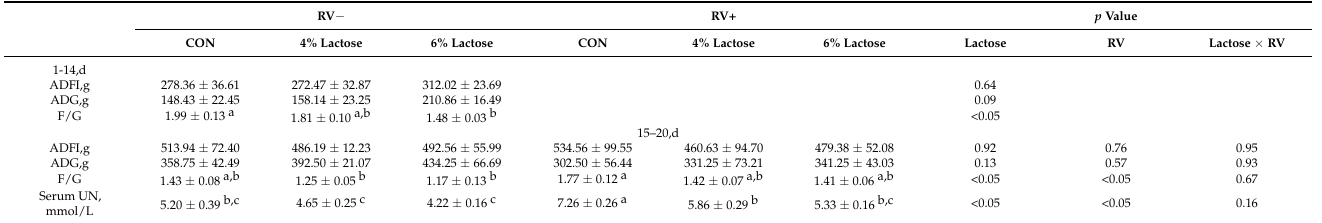
Table 4. Effect of dietary lactose supplementation and/or RV challenge on growth performance and serum UN concentration in weaned pigs 1 .